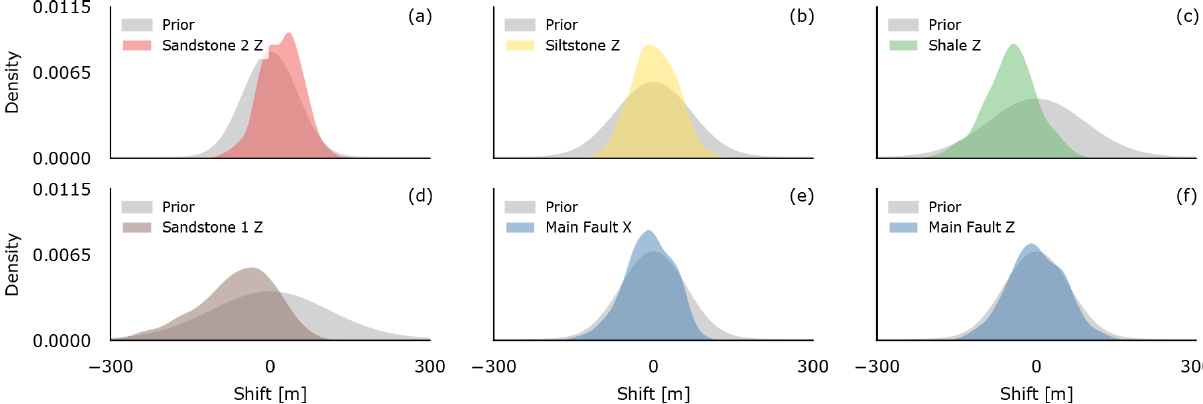
Figure 8. Prior (grey) and posterior (color) kernel density estimations for the different stochastic model parameters for our synthetic fault